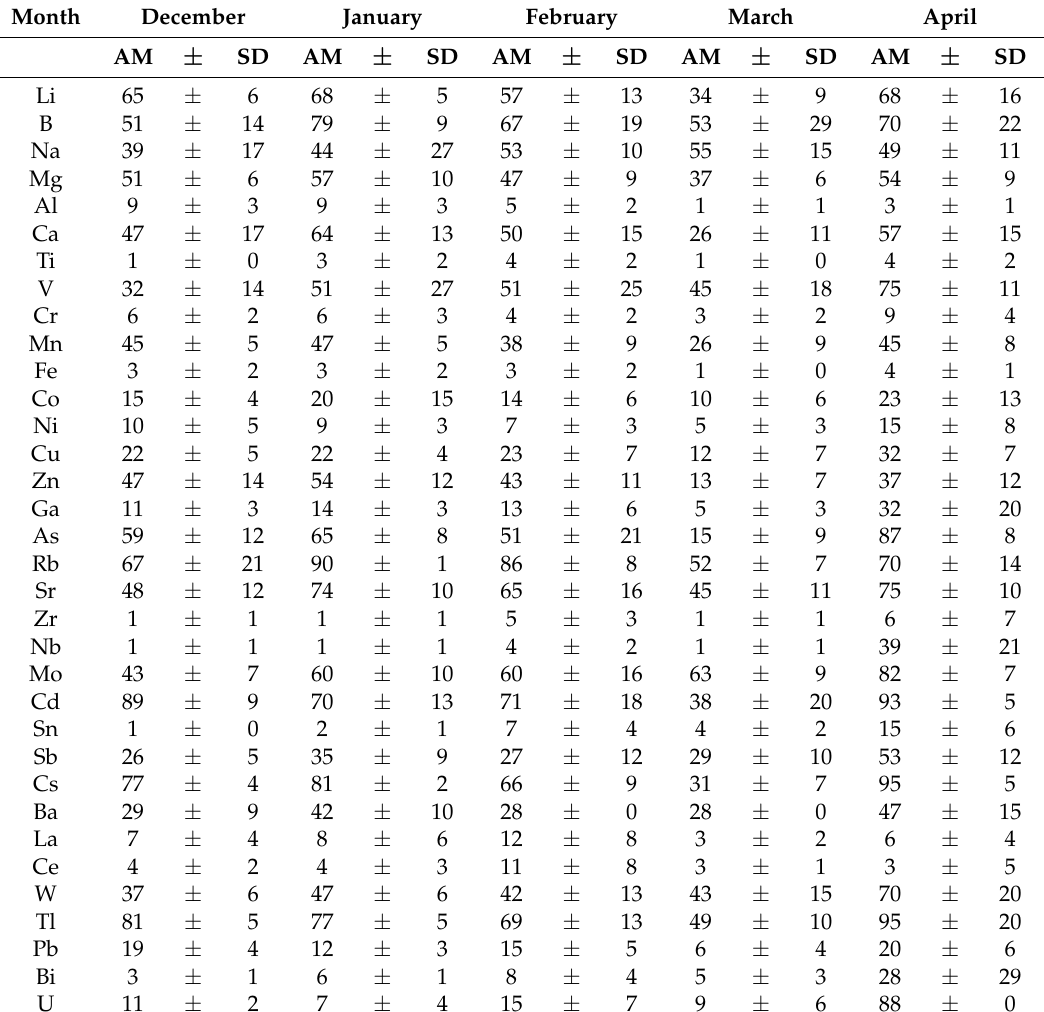
Table 2. Means (AM) and standard deviations (SD) of the elements solubility percentages (%) calculated monthly for each element at all the 23 monitoring